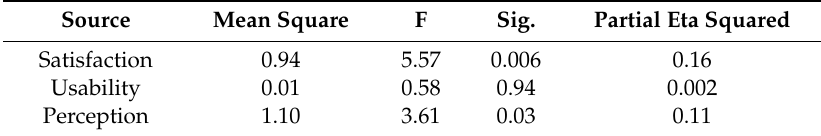
Table 5. ANOVA result for spatial ability on student satisfaction, usability, and perception.